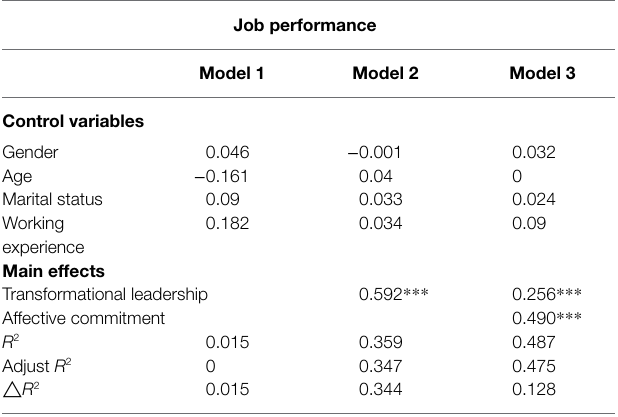
TABLE 7 | Regression analysis of transformational leadership, affective commitment, and job